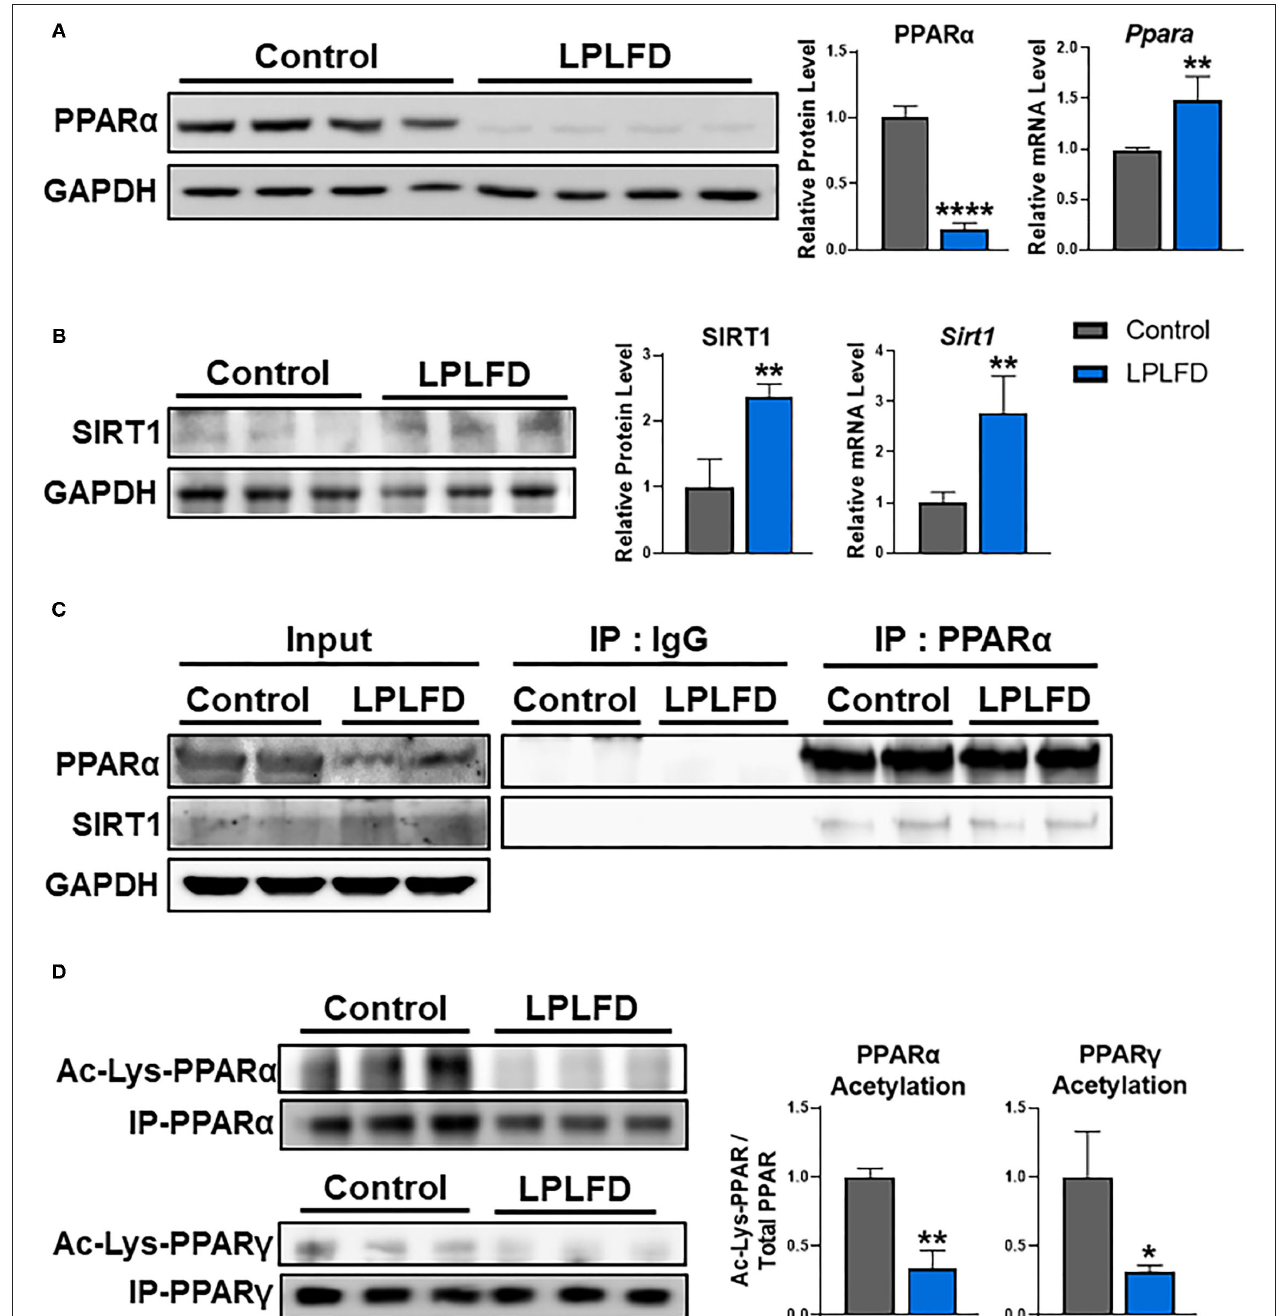
FIGURE 2 | Effects of undernutrition on hepatic PPAR α expression and acetylation in male mice. (A) Whole livers from undernourished mice contained decreased PPAR α protein and increased PPAR α transcript relative to livers from control male mice. (B) Expression of SIRT1 was increased in undernourished livers at both the protein and the transcriptional level. (C) SIRT1 protein was detected bound to PPAR α purified from whole liver by immunoprecipitation, suggesting a direct interaction in control and undernourished mouse livers. (D) PPAR protein was immunoprecipitated from liver, then comparable amounts were analyzed by western blot to illustrate decreased acetylation of both PPAR α , which is not known to be an acetylation target of SIRT1, and PPAR γ , which is a well-known acetylation target of SIRT1. Mean + SD; n = 2–4; **** P < 0.0001; ** P < 0.01; * P < 0.05. Ac-Lys, acetylated lycine; GAPDH, glyceraldehyde 3-phosphate dehydrogenase; IgG, immunoglobulin G; IP, immunoprecipitation; LPLFD, low-protein, low-fat diet; PPAR, peroxisome proliferator-activated receptor; SIRT1, NAD-dependent deacetylase sirtuin-1.